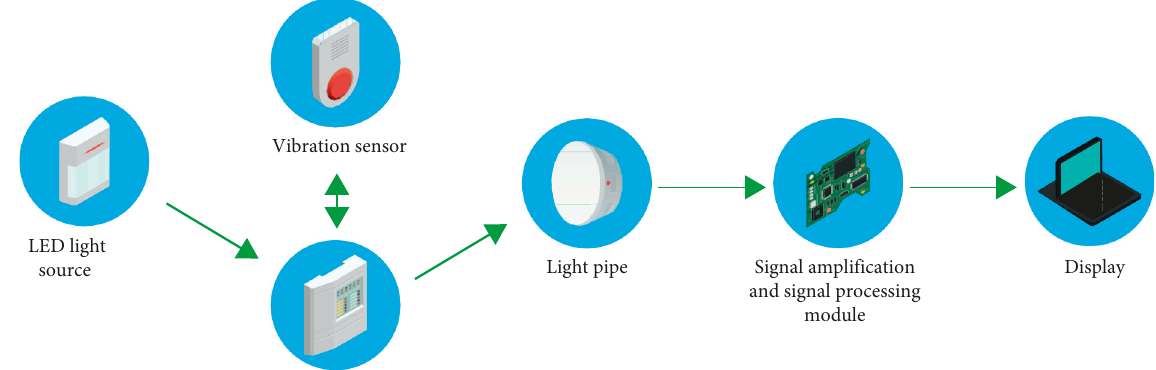
Figure 1: The intelligent sensor of the Lagrange dynamics